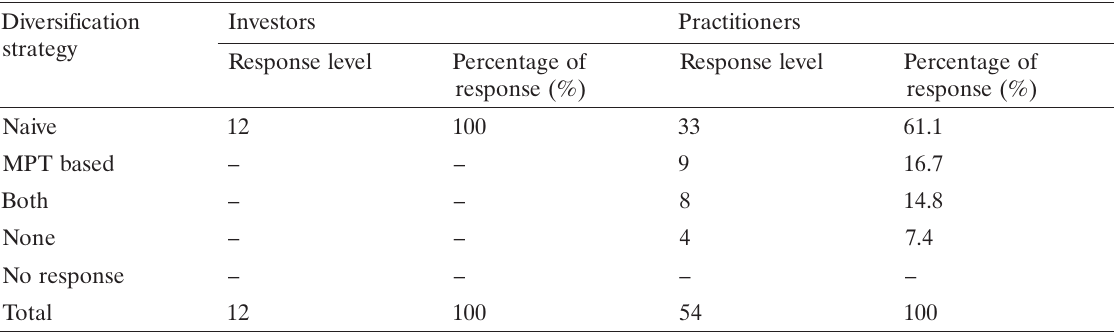
Table 1. Diversification strategy adopted by real estate investors and practitioners noitacifisreviD